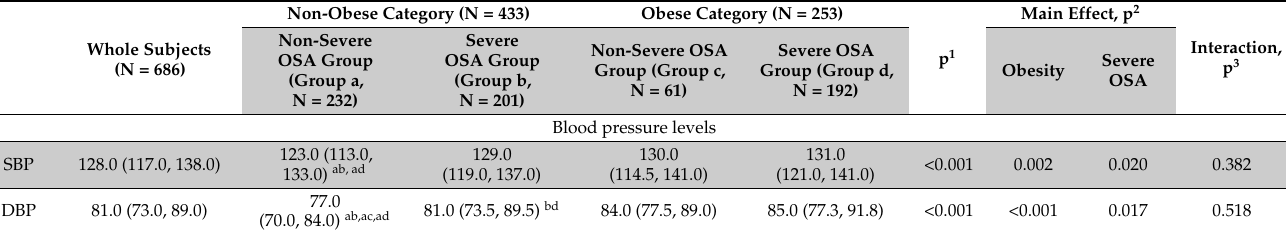
Table 2. Blood pressure levels stratified by obesity and severe